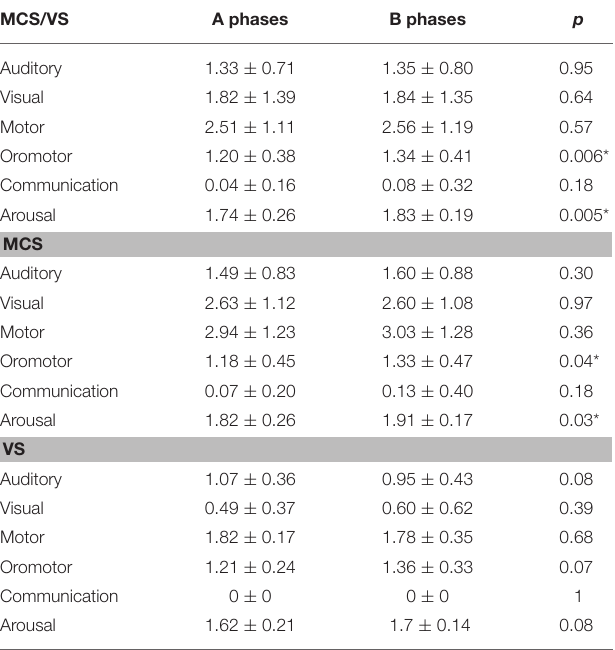
TABLE 2 | Results for the Wilcoxon tests performed to compare CRS-R subscores (average ± standard deviation) during A phases and B phases for both VS and MCS groups but also within each group,